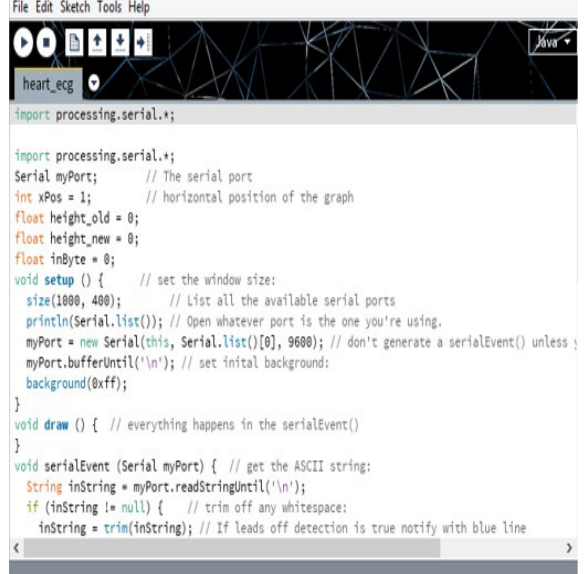
In order to enable developers to interact with digital radio frequency (RF) modules, XCTU software is designed as a free multi-platform application and is simple to use graphical interface. Before programming the ZigBee module, it must be placed on the Zjgbee adapter and Figure 6. Generating ECG Wave on PC using connected with the USB cable to a PC. Both Tx and Rx processing IDE ZigBee modules of S1 series should be tested first through XCTU software as shown in figure 7. In our design, we have set all the baud rates to 9600, as shown in figure